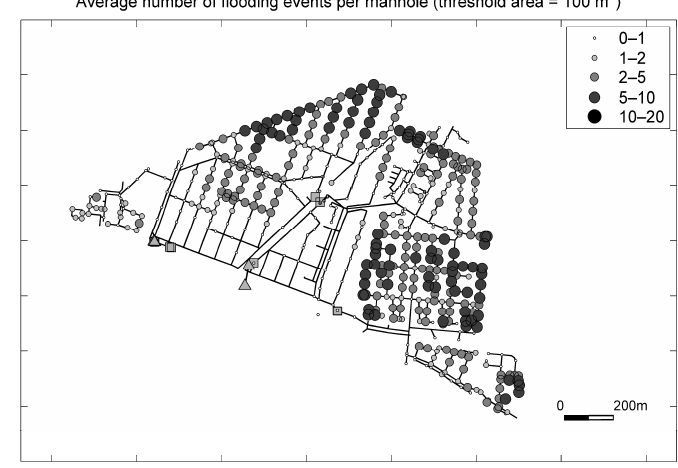
Figure 7. Average number of flooding events per manhole based on the Monte Carlo simulations for the ‘Tuindorp’ catchment.